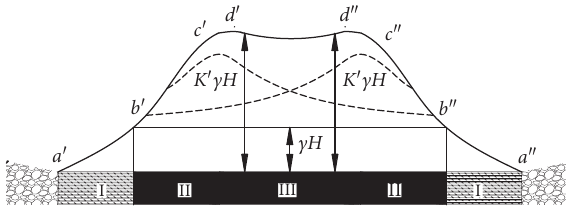
Figure 9: Both sides of the coal pillar are mined out.